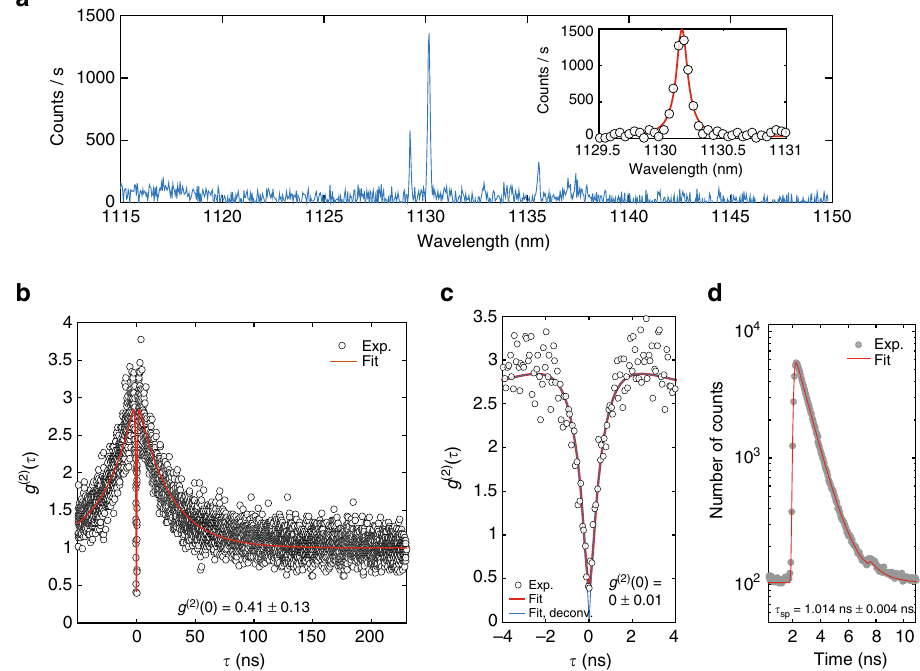
Fig. 5 Quantum dot-waveguide coupling. a Photoluminescence spectrum for a single QD inside a GaAs waveguide as in Fig. 3e, pumped with 1061 nm wavelength laser light. The PL is transferred to the bottom Si 3 N 4 waveguide, and collected with a lensed optical fi ber inside of a Liquid Helium fl ow cryostat (Supplementary Note 6). Sharp lines are exciton transitions from a single QD. Inset: Fit of PL peak at 1130.18 nm. b Second-order correlation as a function of time delay τ for the 1130.18 nm line. Circles mark experimental data, red line is a fi t (Methods section and Supplementary Note 7). c Zoom-in of b near τ = 0. The blue curve and quoted g (2) (0) are obtained from the red fi t by deconvolving the detection time-response. Uncertainties for g (2) (0) are 95% fi t con fi dence intervals (two standard deviations). d Photoluminescence decay trace for the 1130.18 nm line. Gray dots are experimental data, the red line is a fi t with a monoexponential function with lifetime τ fi t and corresponds to a single standard sp . The uncertainty is obtained from the